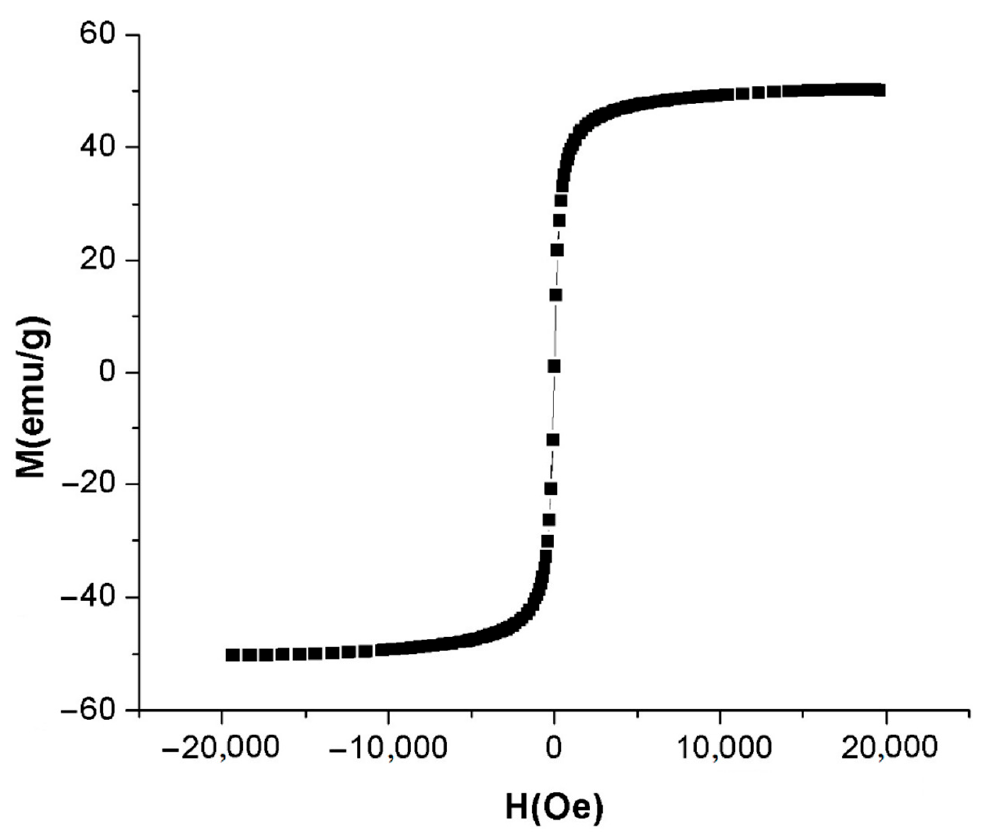
Figure 7. Magnetization curve of the synthesized A-IONPs. Using magnetization data, the average size of the magnetic core diameter was